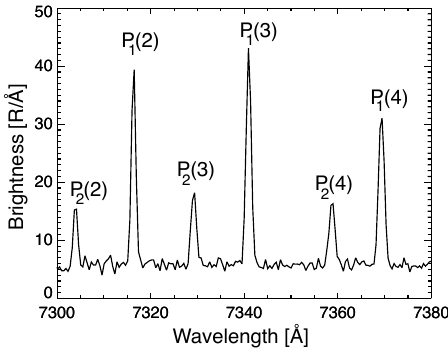
Figure 2. Example clear-sky HiTIES spectrum, showing labelled OH emission lines. Taken on 23 December 2003 at 22:30 UT, with an integration time of 120s.